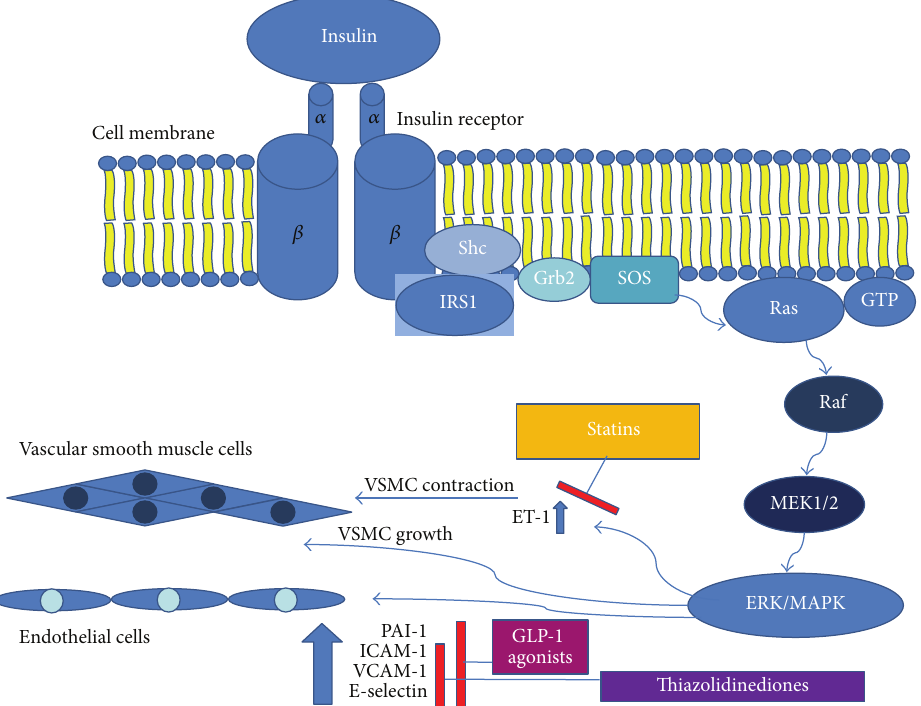
Figure 1: Insulin signalling in vessels. 𝛼 : alfa subunit of insulin receptor; 𝛽 : beta subunit of insulin receptor; Shc: Src homology and collagen protein; Grb2: cytosolic growth factor receptor-bound protein 2; IRS1: insulin receptor substrate; SOS: proline-rich domain of the son of sevenless; Ras: family of related proteins; Raf: serine/threonine specific protein kinases; MEK1/2: mitogen-activated protein kinase; ERK/MAPK: mitogen-activated protein kinase; ET-1: endothelin-1; GLP-1: glucagon-like peptide; PAI-1: plasminogen activator inhibitor; ICAM-1: intercellular adhesion molecule 1; VCAM-1: vascular cell adhesion molecule